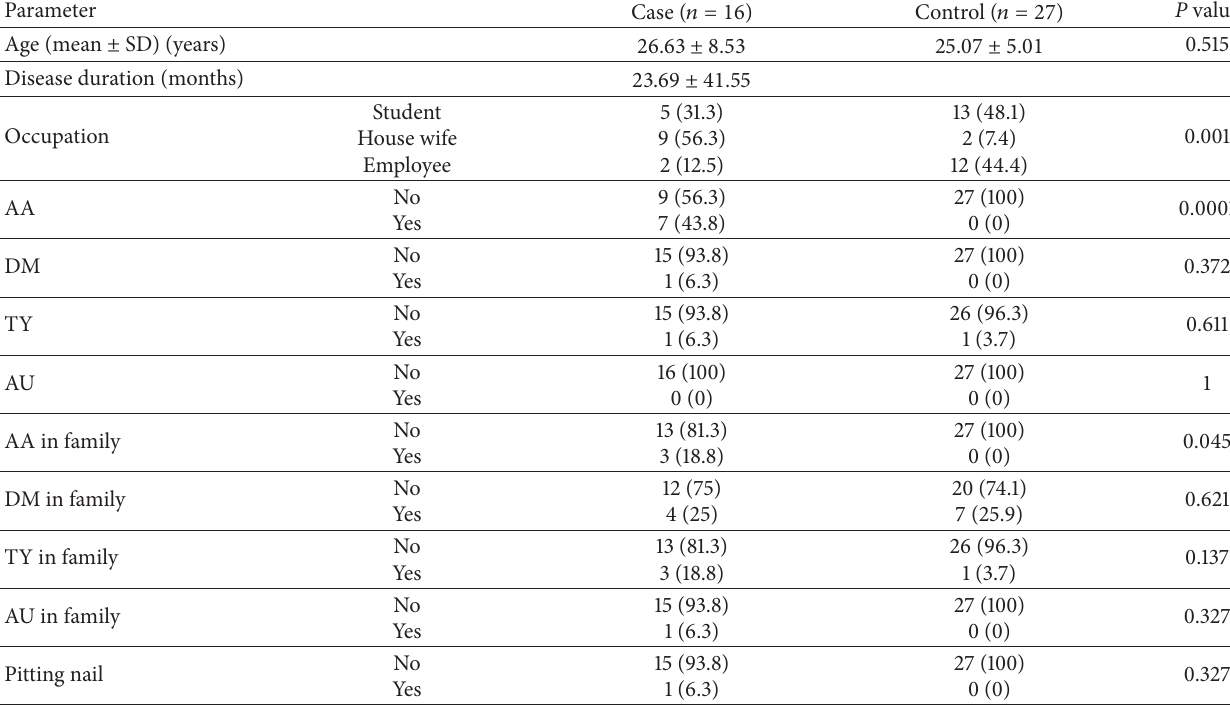
Table 1: Baseline demographics and associated diseases among patients and controls.